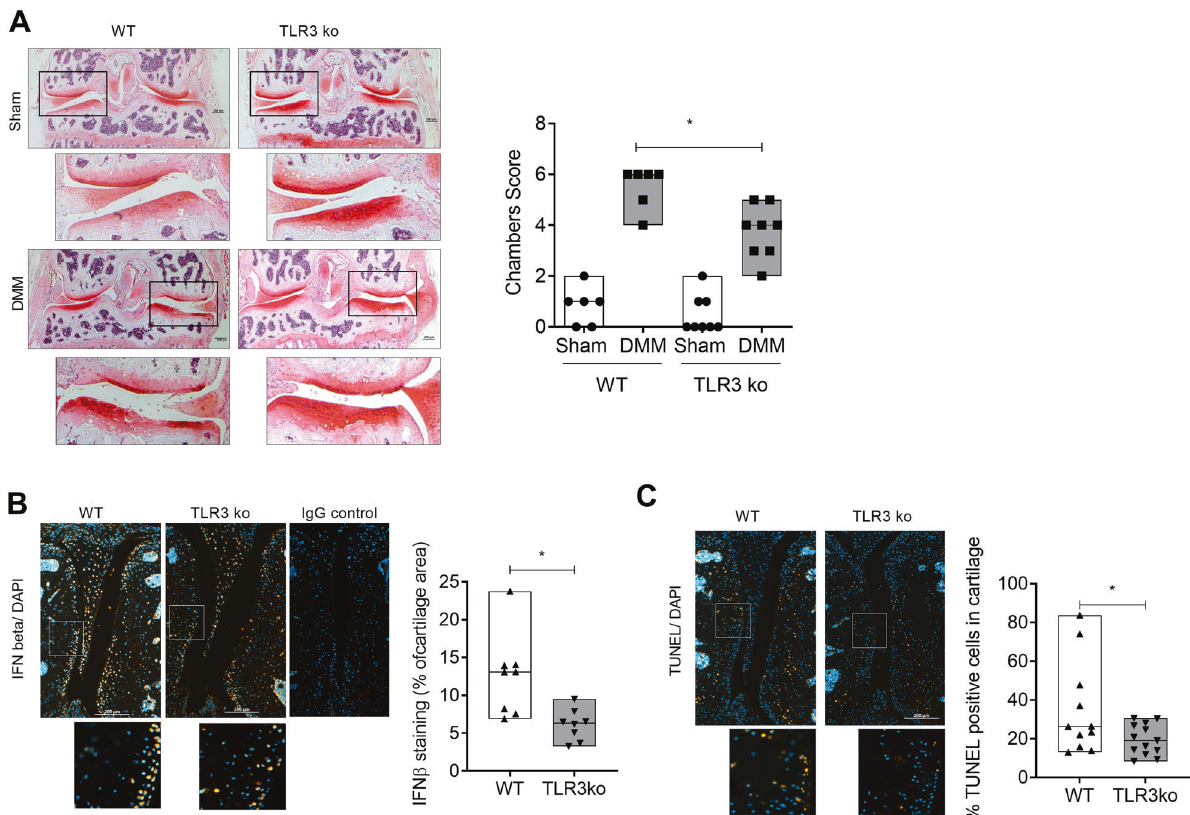
Fig. 3 Inhibition of TLR3 dependent signalling protects mice from OA like cartilage changes. A Representative safranin-orange stained frontal knee joint sections of WT and TLR3 − / − mice after 8 weeks of DMM induction and the respective sham operated controls (Scale bar: 200 µm). The OARSI Score was used to quantify OA in the given graph (one-way ANOVA: F (3,24) = 51.60; p < 0.0001, WT N = 6, TLR3 − / − N = 8, Holm-Sidak post-hoc test DMM WT vs DMM TLR3 ko: 1.750, p = 0.002). B Representative pictures of IFN β immunostaining in the medial knee joint compartment of DMM induced WT and TLR3 − / − mice. The quanti fi cation of IFN β positive staining cartilage area is given in the graph (Scale bar: 200 µm, t-test: WT: 12.57 ± 1.92, TLR3 − / − : 6.09 ± 0.73; p = 0.007, N > 6). C Representative TUNEL stainings of DMM induced medial compartment of WT and TLR3-/- frontal knee joint sections. Quanti fi cation of TUNEL positive cells in relation to number of DAPI positive nuclei TLR3 − / − mice also show fewer positive chondrocytes (Scale bar: 200 µm, t-test: WT: 34.87 ± 7.26, TLR3-/-: 19.64 ± 2.19; p = 0.042, N >